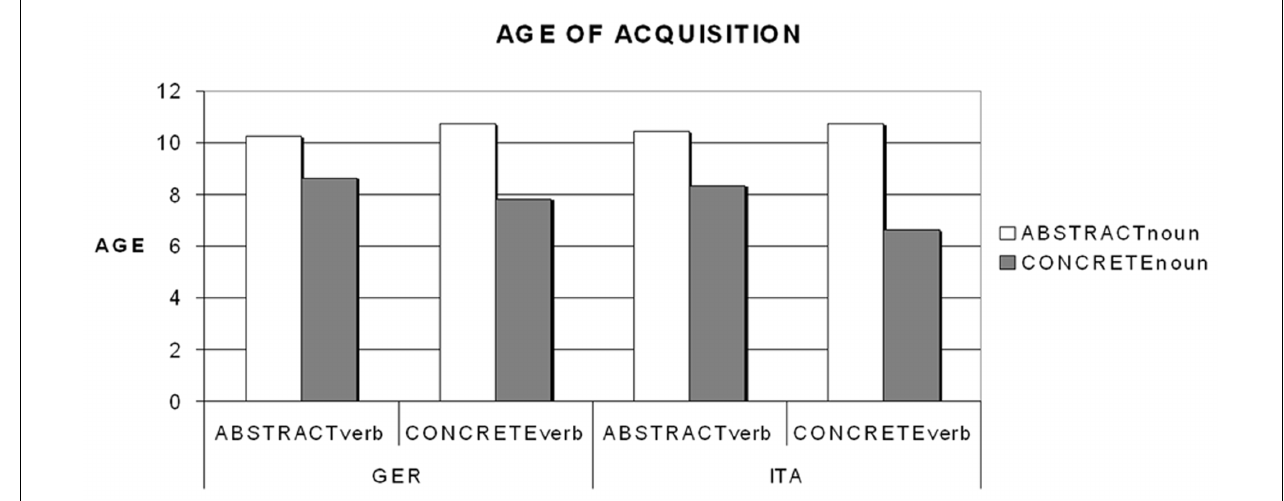
FIGURE 4 | Results suggest that the different age of acquisition of sentences is explained by the noun: as shown in the literature on single word age of acquisition, the concrete noun is learned before than the abstract one.